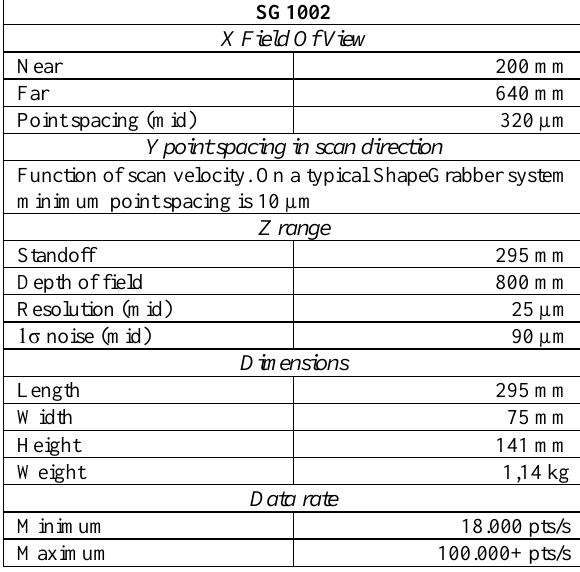
Table 1. SG1002 technical data.